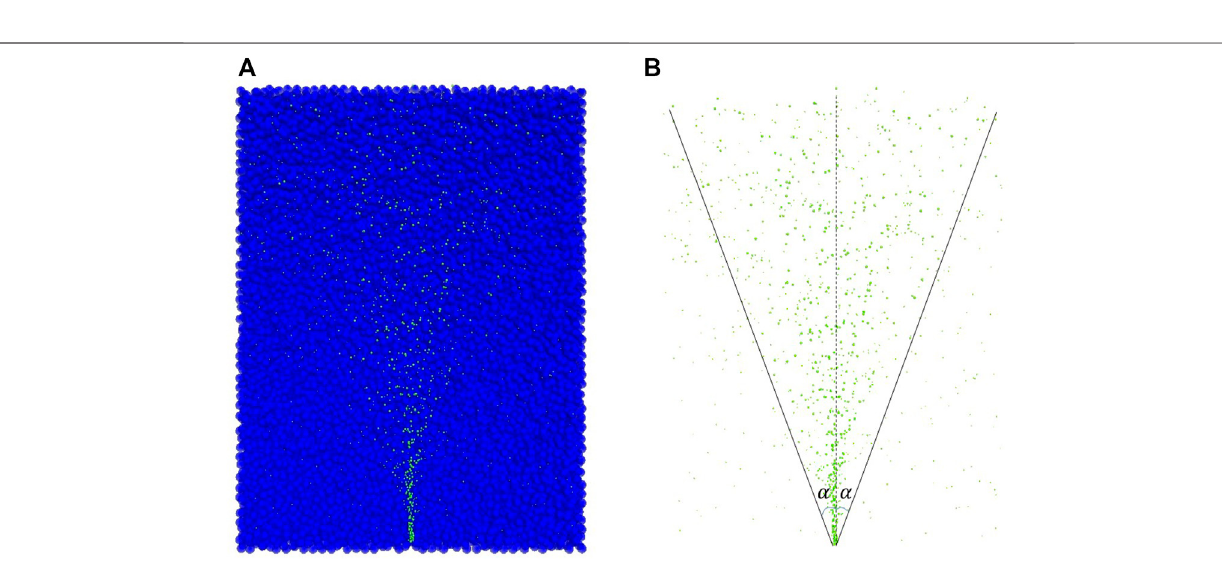
Frontiers in Physics |